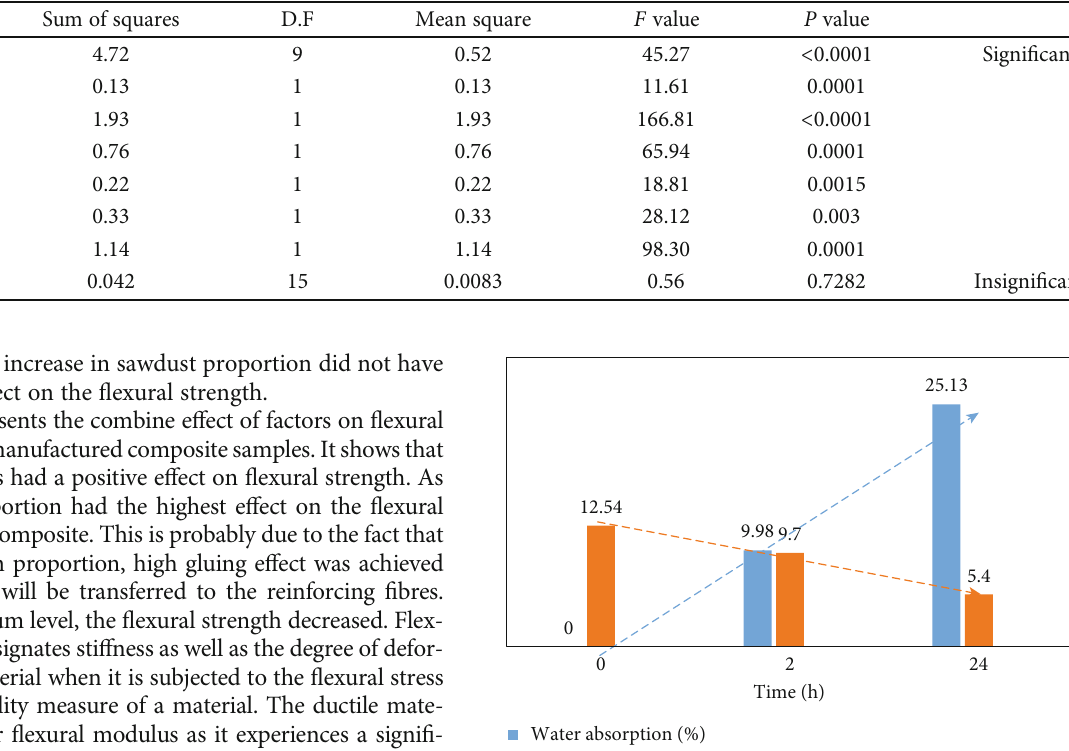
Figure 6: E ff ect of fi bres, sawdust, and resin on fl exural strength of the composite. Table 5: ANOVA table for composite fl exural strength.